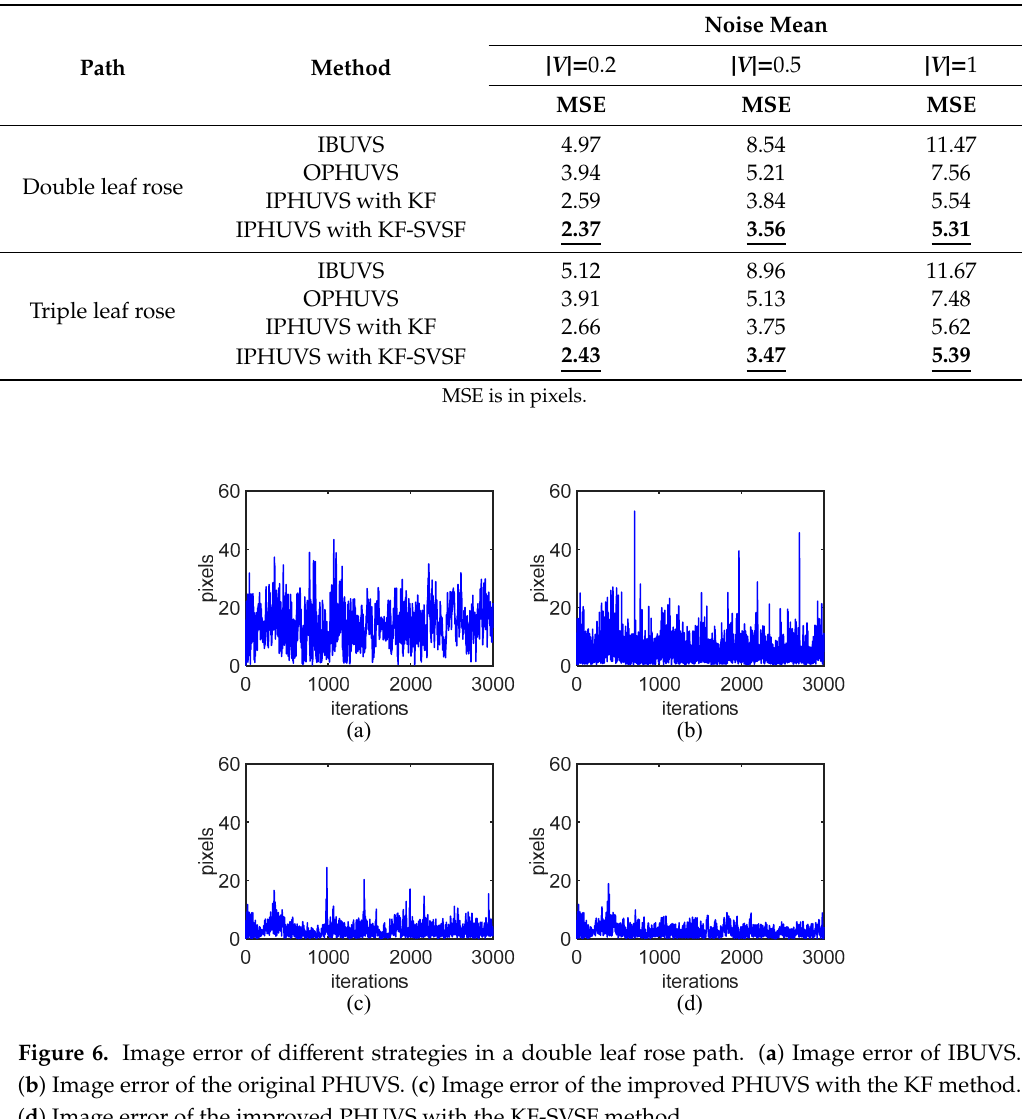
Table 3. Mean square error (MSE) of di ff erent strategies in the dynamic tracking test.